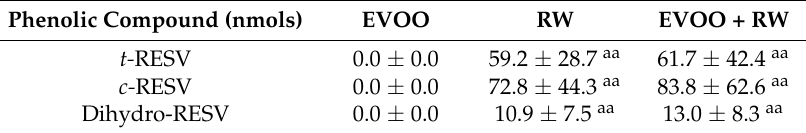
Figure 1. RESV urinary recovery (nmol) from 0 to 6 h after RW and RW + EVOO of ( A ) t- RESV; ( B ) c- RESV; and ( C ) Dihydro-RESV. Data expressed as mean ± SD. Table 2. RESV urinary recovery (nmol) from 0 to 6 h after treatments.